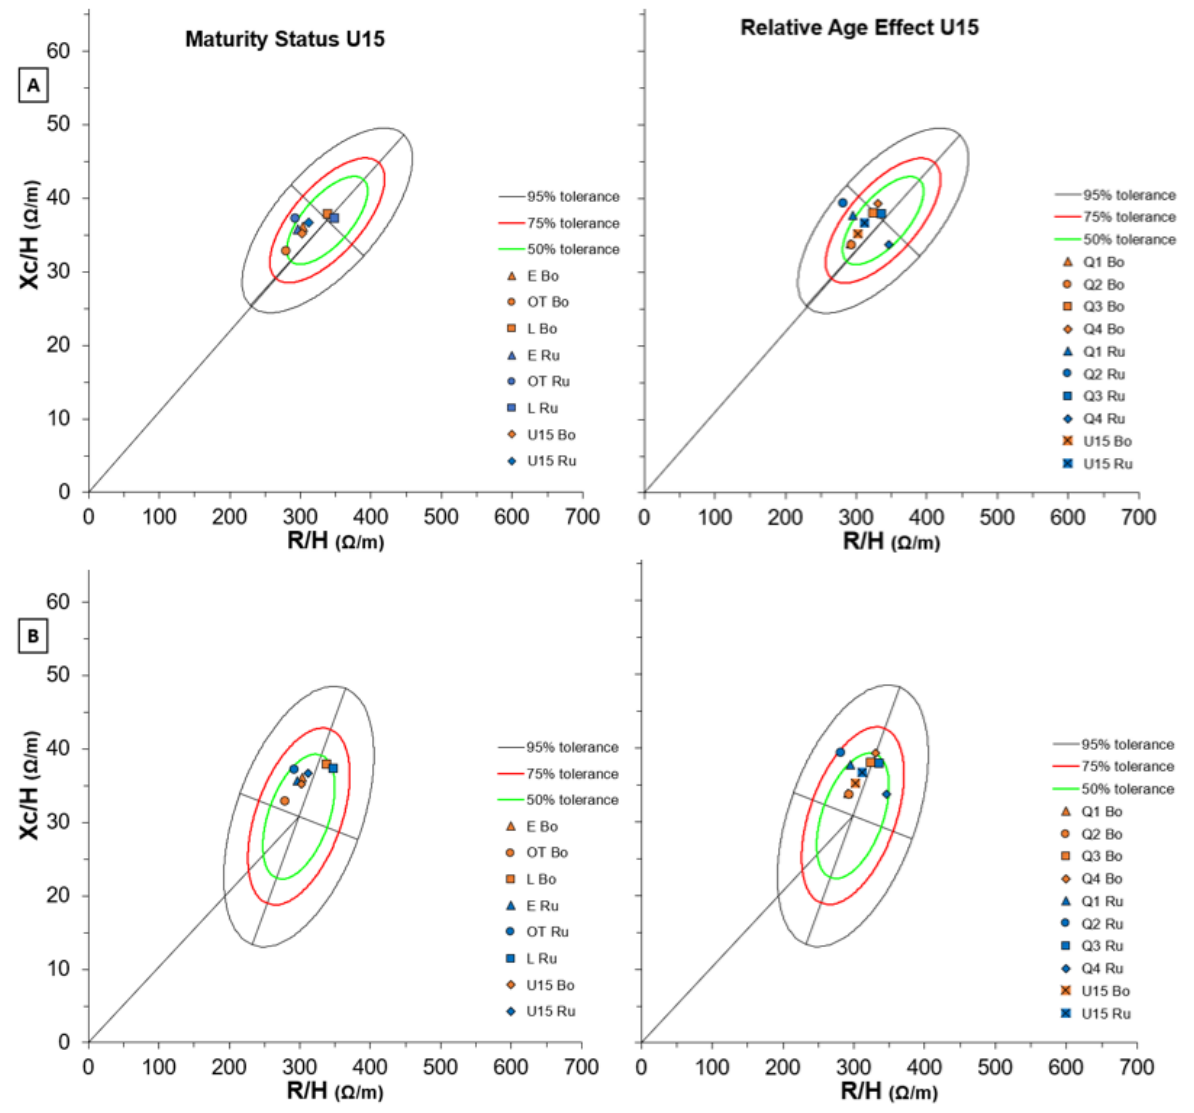
Figure 9. BIVA tolerance with Maturity Status (left) and Relative Age Effect (right) of both Bologna and Russi U14 groups for two reference populations: ( A ) number 118 (Males + Females, White, age 14 – 15 years, BMI 20, Italy, Akern-RJL Systems); ( B ) the number 1 (Males, White, 16 age 85 years, 16 BMI 31, Italy, Akern-RJL Systems). Note: U15 Bo and U15 Ru refer to team means respectively.